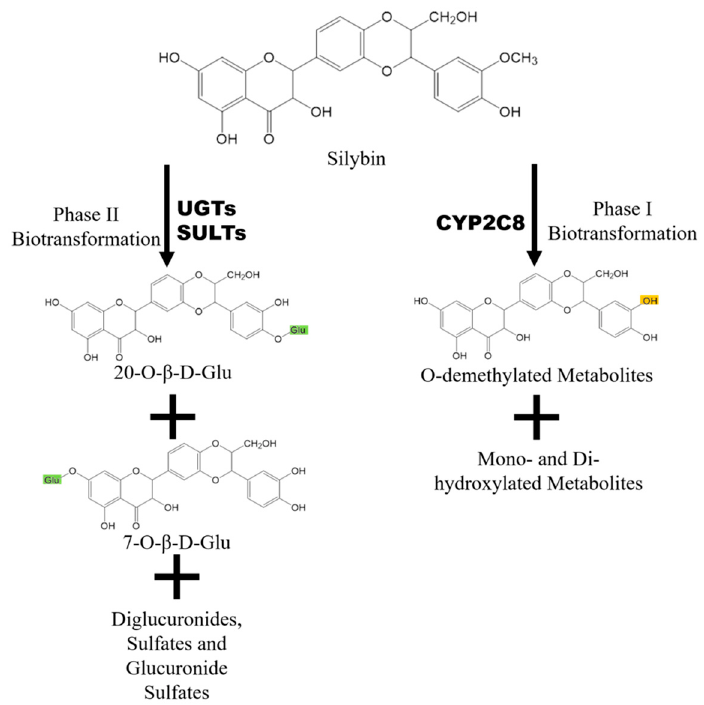
Figure 3. Metabolism of silybin and its major metabolites. UGT: UDP-glucuronosyltransferase; SULTs: sulfotransferases; CYP2C8: Cytochrome P450 2C8.